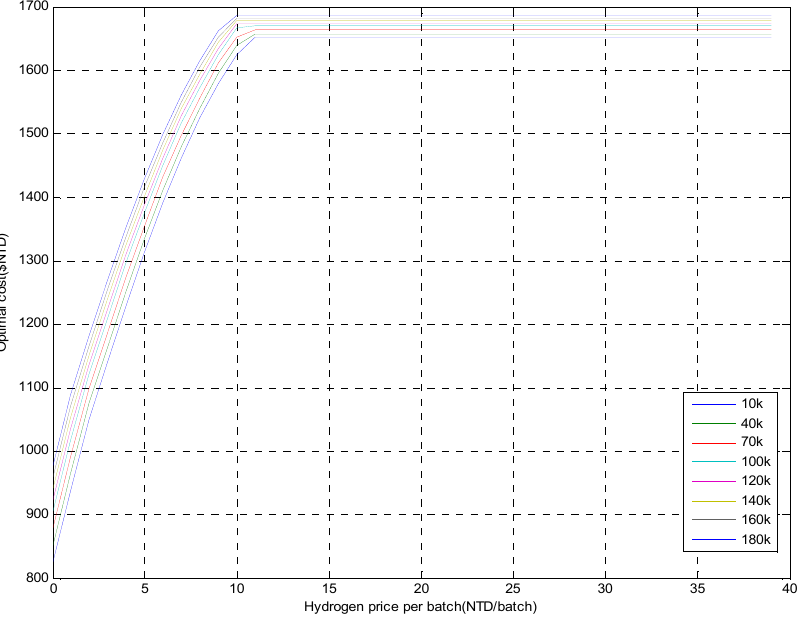
Figure 11. The influence of hydrogen prices on system costs.